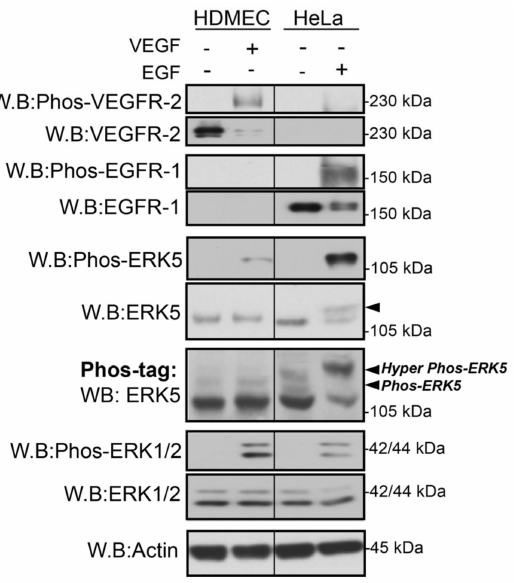
Figure 1. VEGF and EGF stimulate differential ERK5 phosphorylation . HDMECs and HeLa cells were serum-starved overnight prior to stimulation for 10 min with either VEGF (50 ng/mL) or EGF (50 ng/mL), respectively. Cells were lysed in RIPA buffer, and lysates were resolved by 7.5–10% SDS-PAGE or Phos-tag SDS-PAGE and analysed by Western blotting. Results are from one experiment representative of three independent